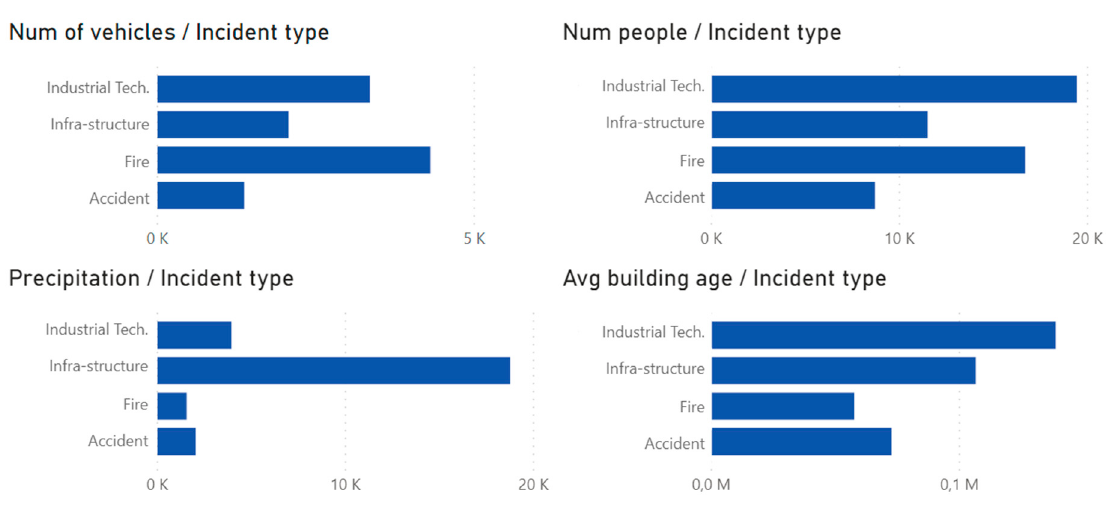
Figure 2. Distribution of occurrences in each variable by incident type.